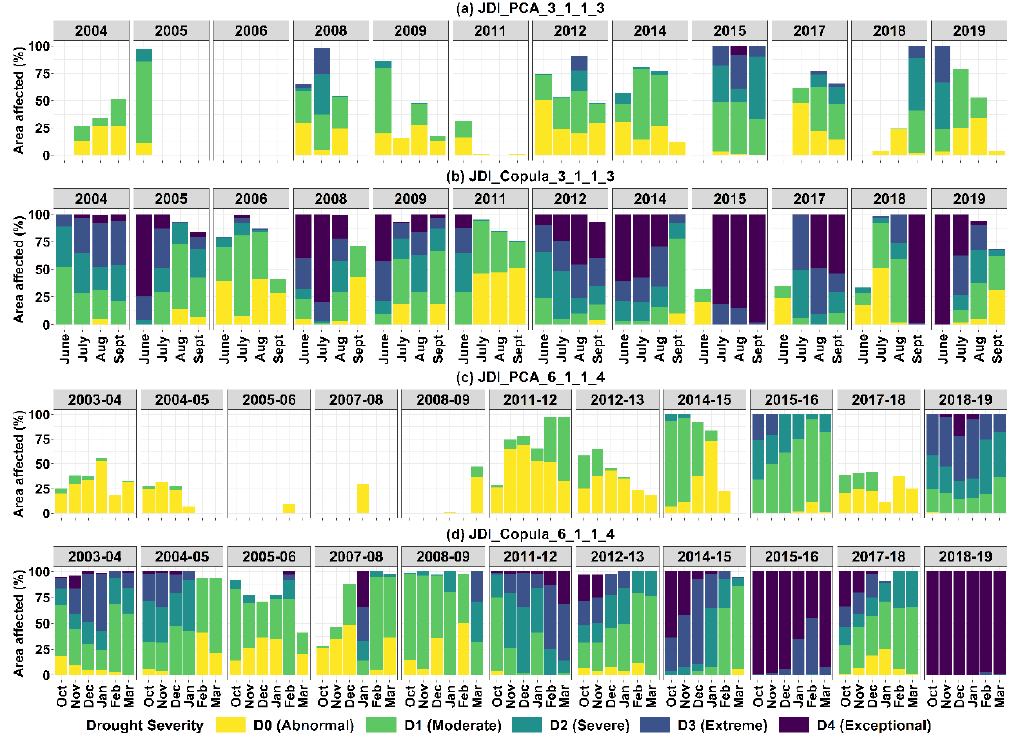
Figure 6. Percentage of drought area in each month of Kharif ( a , b ) and Rabi ( c , d ) season for different drought events during 2003 to 2020 using PCA ( a , c ) and copula ( b , d ). Drought severity varies from D0 (yellow bars with least severity) to D4 (dark blue bars with highest severity).